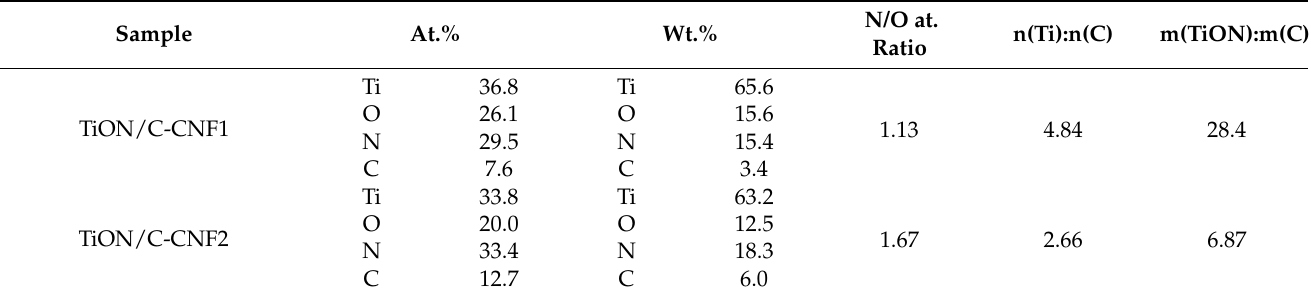
Table 1. Composition of samples TiON/C - CNF1 and TiON/C - CNF2 . The composition was ob- tained from SEM EDXS spectra in Figure S16.